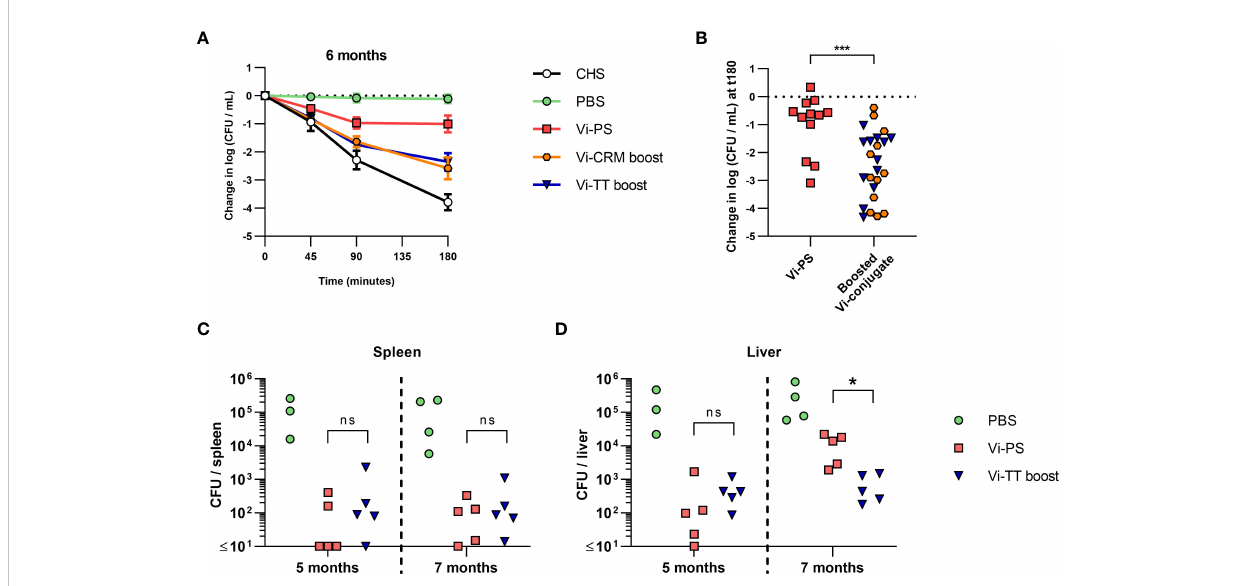
FIGURE 6 Bactericidal activity of mice immunized with Vi vaccines over time and the effect on protection. C57Bl/6 mice were immunized i.p with PBS, 4 µg Vi- PS, on day 0, or 2 µg Vi-CRM 197 or Vi-TT at both day 0 and 35. (A) Serum bactericidal activity of sera collected day 185 (6 months post-primary immunization) was measured against TH177, represented as mean change from the starting LogCFU/mL bacterial dose over time, normalised to the negative control values at each timepoint. Complete human serum (CHS) was used as a positive control. Error bars represent SEM. (B) Serum bactericidal activity from the 180-minute timepoint represented as mean change from the starting LogCFU/mL between mice immunized once at day 0 with Vi-PS. or twice at day 0 and 35 with Vi-CRM 197 or Vi-TT. (C) Spleen or (D) Liver colony forming units (CFU) of C57Bl/6 (WT) mice immunized i.p with 4 µg Vi-PS or PBS on day 0, or 2 µg Vi-TT at both day 0 and 35 then infected for 24 hours with 1x10 5 CFU Vi+ S. Typhimurium TH177 at day 154 or 201 (5 or 7 months post-primary immunization). Representative of 2 experiments with n = 4 or 5 mice/group. For B-D each point represents data from one mouse. Serum bactericidal activity of sera taken day 199 (prior to day 202 infection), represented as change from the starting LogCFU/mL bacterial dose normalised to the negative control values at each timepoint, or at the 180 minuet timepoint alone. Complete human serum (CHS) was used as a positive control. Groups contain 4-5 mice/group and in the right hand graph each point represents one serum. *p ≤ 0.05, ***p ≤ 0.005, and ns = non-signi fi cant by Mann-Whitney U test between individual groups